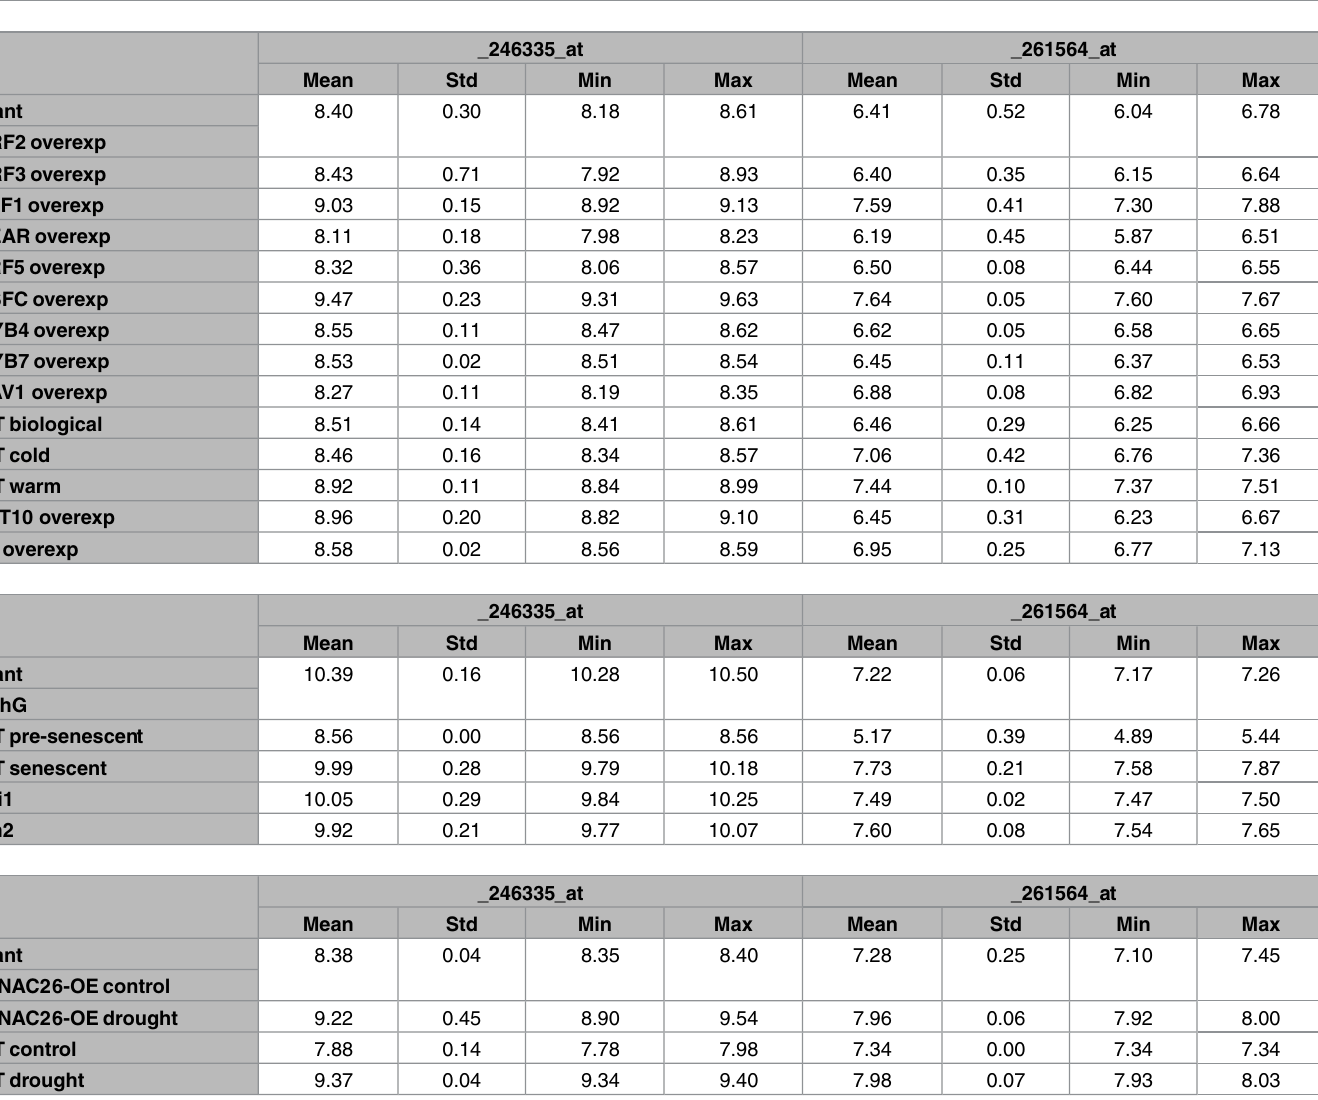
Table 3. Frequency analysisof PAO and ATAF1 by plantline. Both PAO (left-side)and ATAF1 (right-side) expression differed by plant line in a positively correlatedmannerin the GSE55907, GSE5727, and GSE72050microarray datasets, wherePAO and ATAF1 levels were eitherboth high or both low in each plant line. A. PAO and ATAF1 levels were higherin warmconditions and certaintranscription factor overexpressing lines such as HSFC overexpressing line, and were lower in the DEAR overexpressing line. B. PAO and ATAF1 levels were higherin wild-typeplants duringsenescent conditions,in mutantjasmonic acid/ethylene pathway lines, and transgenic salicylic acid pathway line. C. PAO and ATAF1 levels were higherin droughtconditions in both wild-typeand NAC26-overexpressing lines and PAO levels somewhat higherand ATAF1 levels slightlylower in NAC26-overexpressing line comparedto